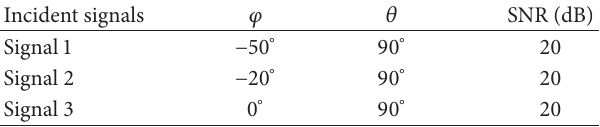
Table 1: Parameters of the incident signals.